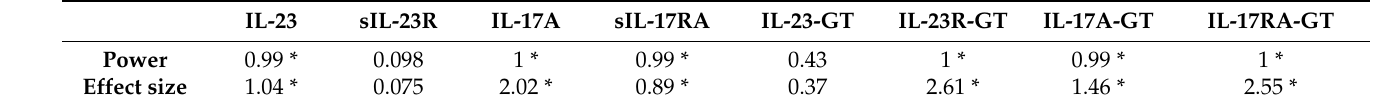
Table 2. Power and effect size of IL-23/IL-17 axes in